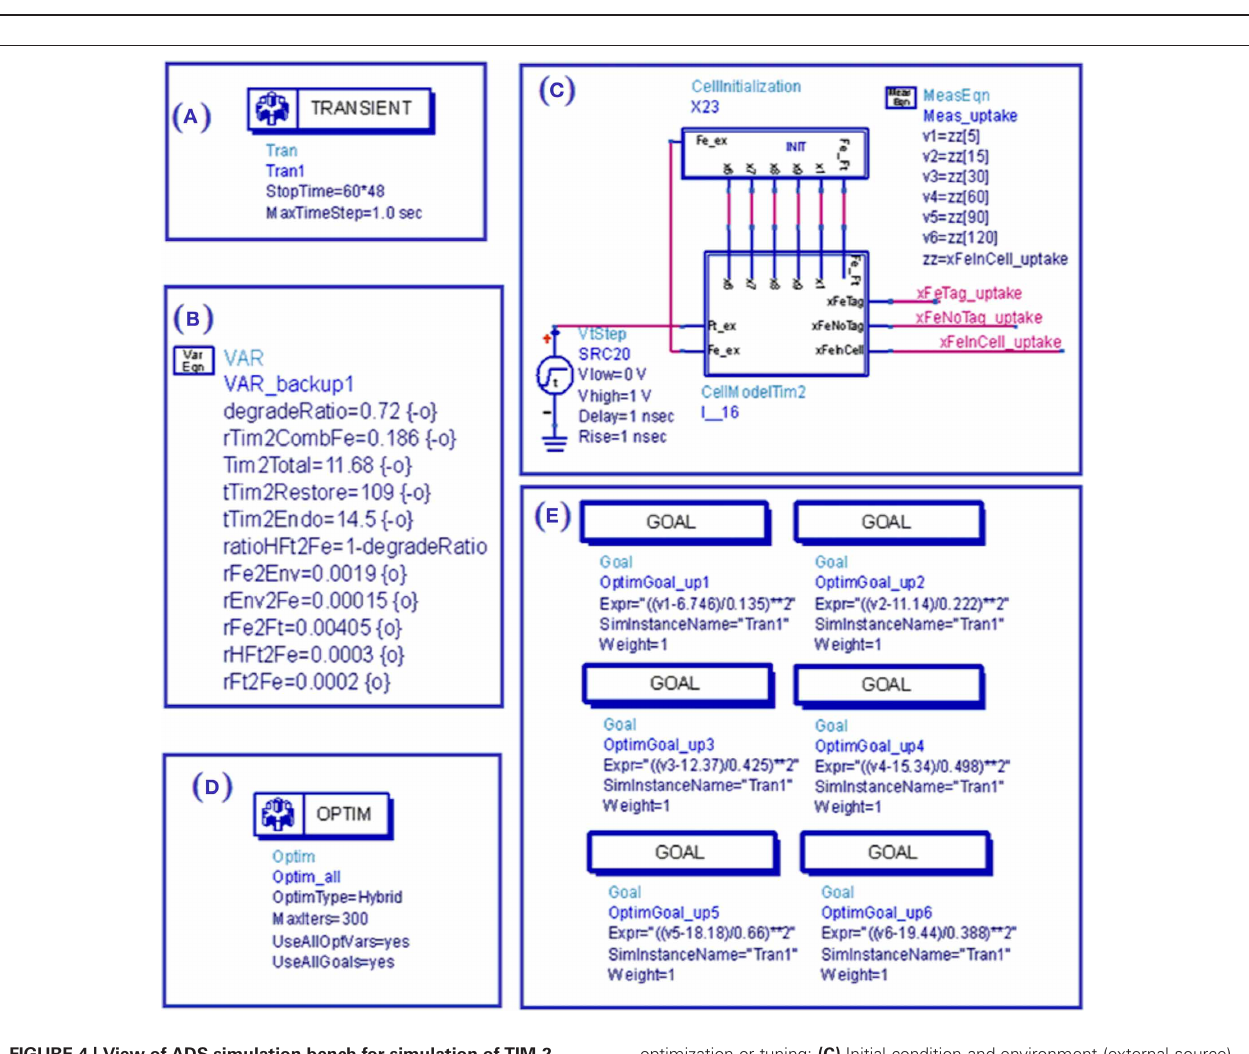
optimization or tuning; (C) Initial condition and environment (external source) as applied to the cell subcircuit through wire connections; (D) Optimization setup of optimization methods and iteration time; (E) Goals for